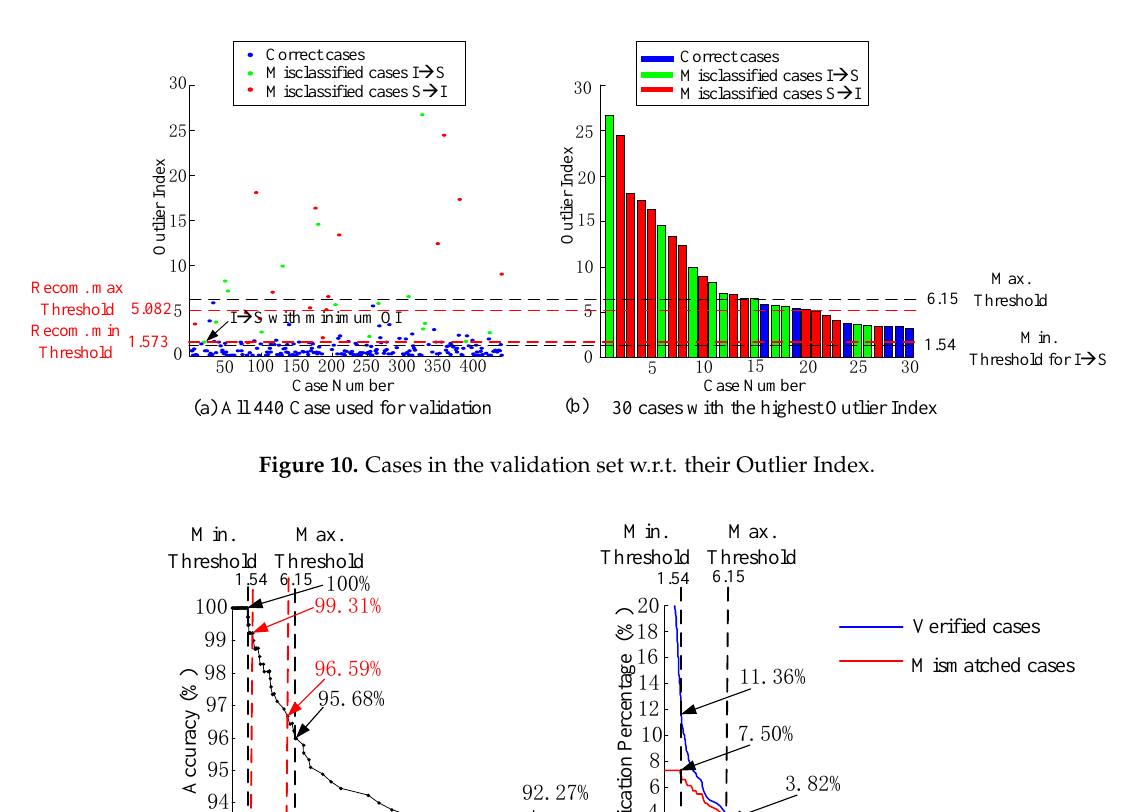
Figure 11. Accuracy and verification percentage w.r.t. different Outlier Index thresholds.